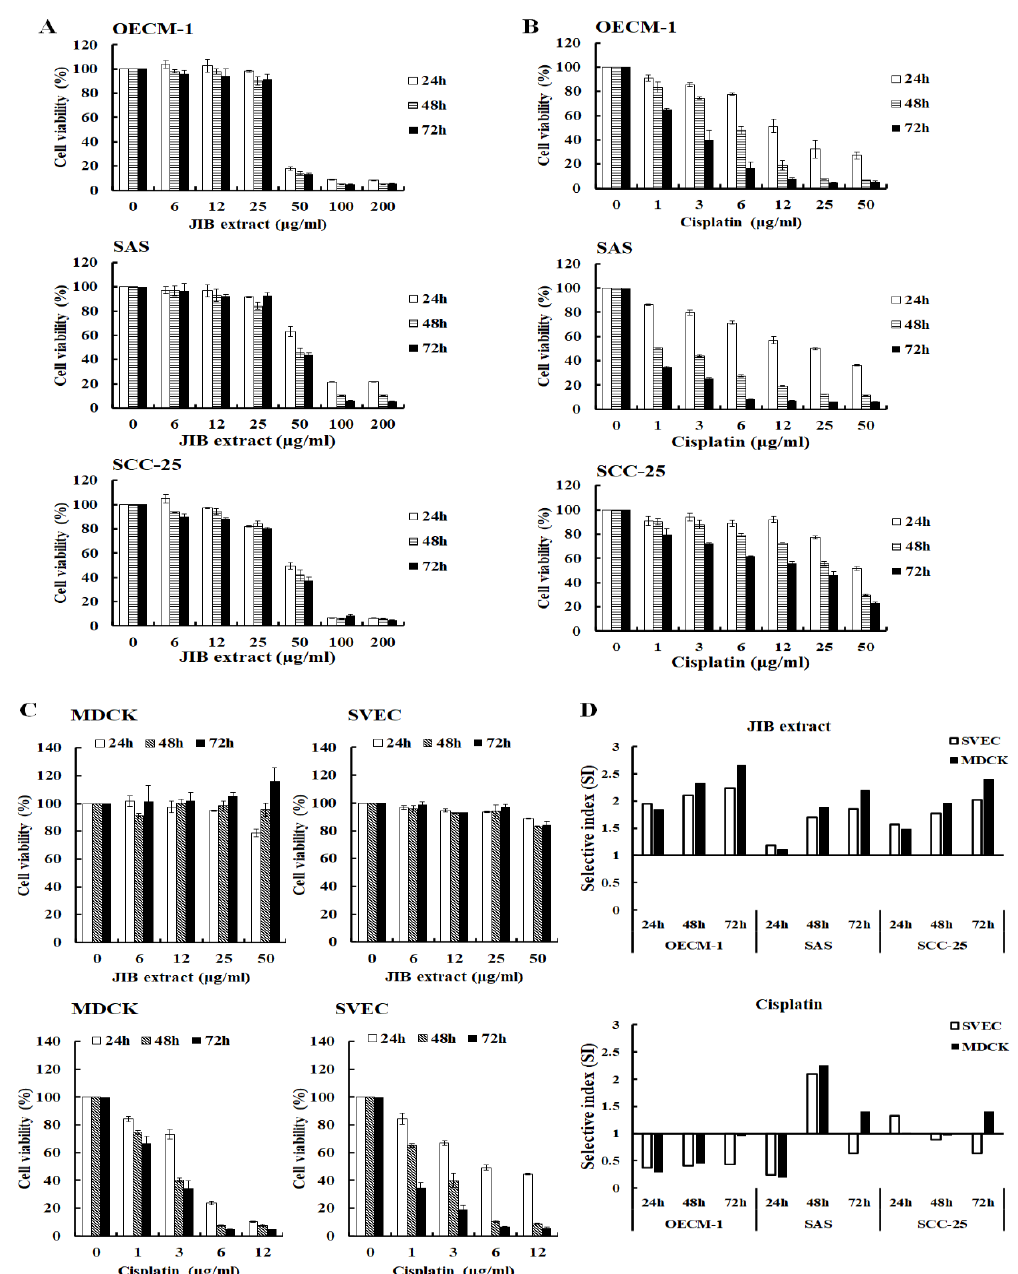
Figure 1. The inhibitory effect of Juniperus indica Bertol crude extract (JIB) on oral cancer cells. Cells were grown in 96well plates and treated with JIB extract or cisplatin at a series of concentrations for 24, 48 and 72 h. The cell viability is presented as the percentage of the mean ± SD. ( A ) Growth inhibition curves following treatment with JIB extract. ( B ) Growth inhibition curves following treatment with cisplatin. ( C ) Normal cells were treated with JIB extract and cisplatin. ( D ) Selective index (SI) of JIB extract and cisplatin in oral cancer cell lines.